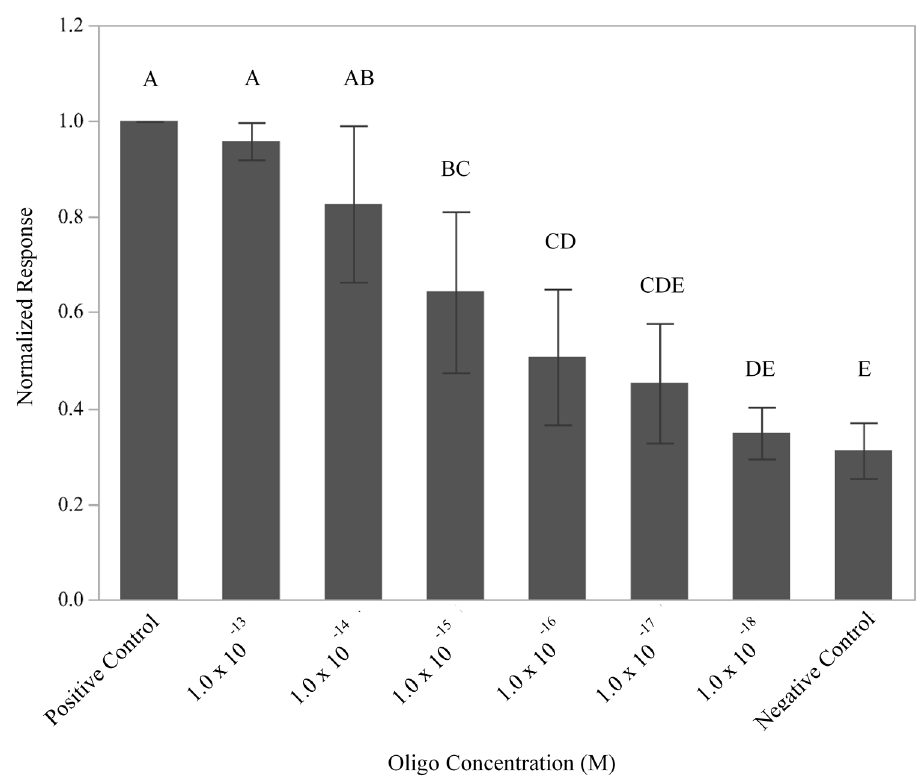
Figure 3. Detection limits for the flow-through, enzyme-amplified electrochemical sensor using oligos as biorecognition elements. The normalized current response was measured for a constant amount of F-2 Link (Biotin) oligo conjugated to the surface of the GFE post exposure to various concentrations (10 − 13 –10 − 18 M) of the complementary oligo, L-2 (HRP). The mean of three independent trials is plotted with the standard deviations and statistical differences amongst samples noted by the connecting letters report. Levels not connected by the same letter are significantly